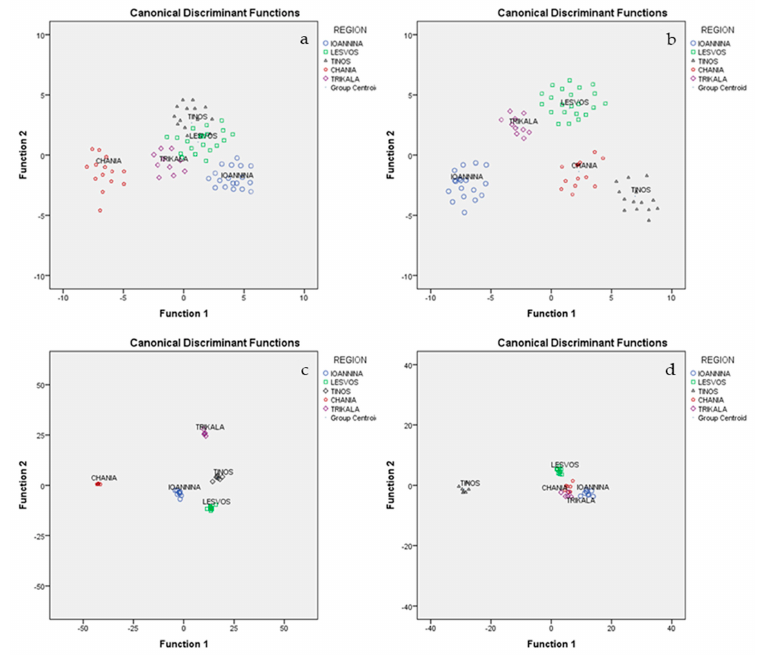
Figure 1. Geographical differentiation of graveria cheeses based on ( a ) CQPs, ( b ) minerals, ( c ) VCs, and ( d ) FA compositions.